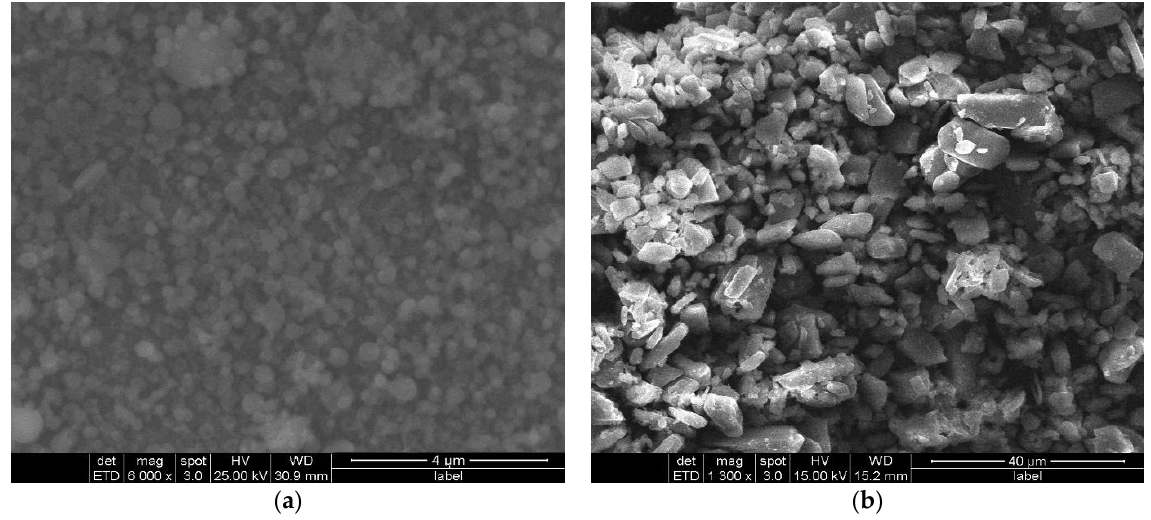
Figure 5. SEM of ( a ) NES-SLN-G and ( b ) NES-G formulations.